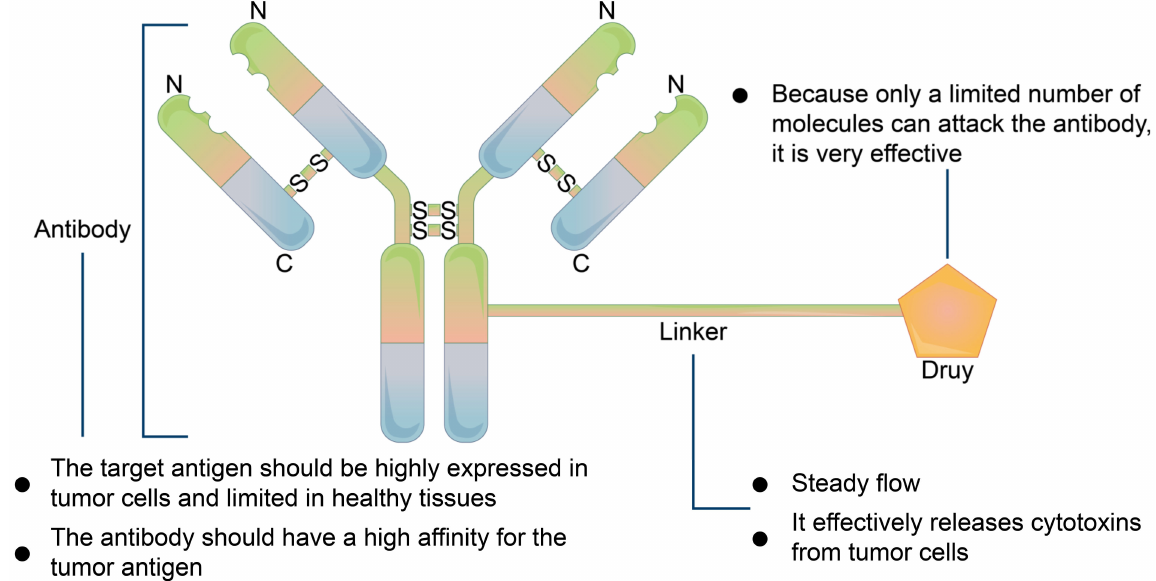
Figure 6. Basic mechanism of antibody-drug compound. The antibody must be highly expressed in tumor cells and limited in normal cells and have a high affinity for the tumor cell receptor. Linker, which must be stable in systemic circulation and can effectively release toxic factors from tumor cells when reaching tumor